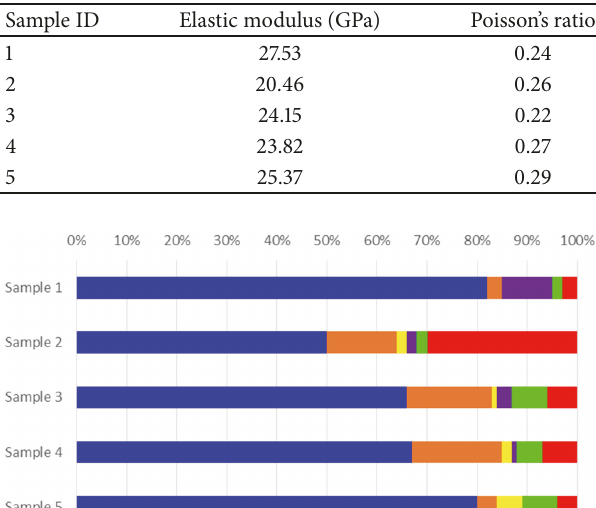
Table 4: Shale elastic modulus and Poisson’s ratio.